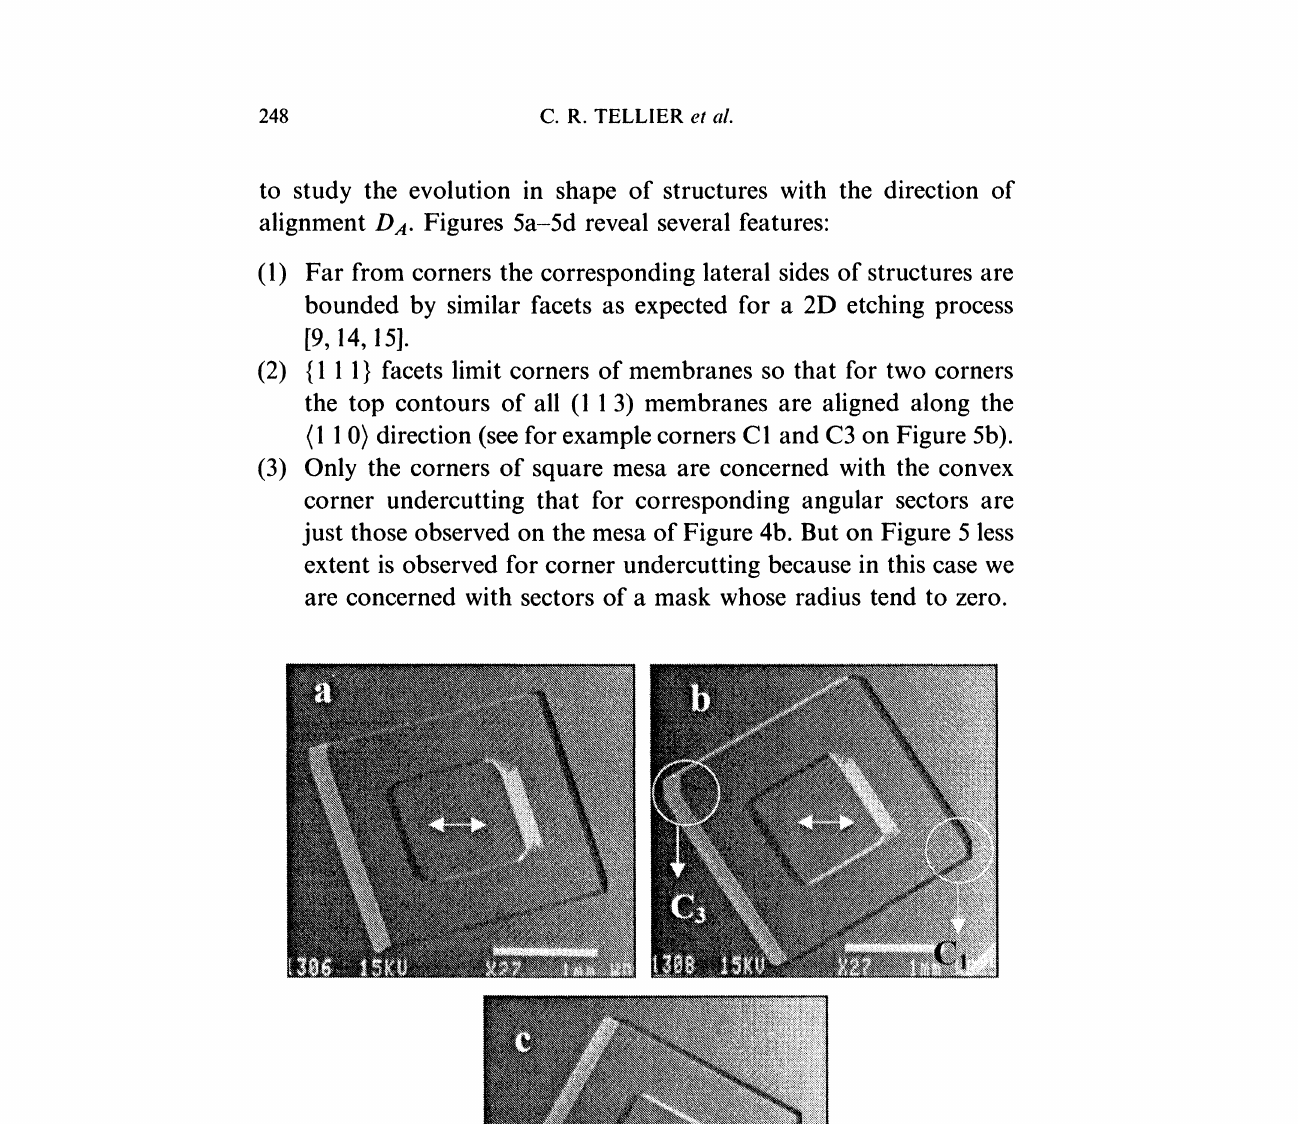
, , FIGURE 5 SEM images of differently aligned (1 13) mesa as obtained with square q’A 30 masks, a, b, c and d are for q’, 15 q’,--60 respectively. Arrows indicate .a the direction of the